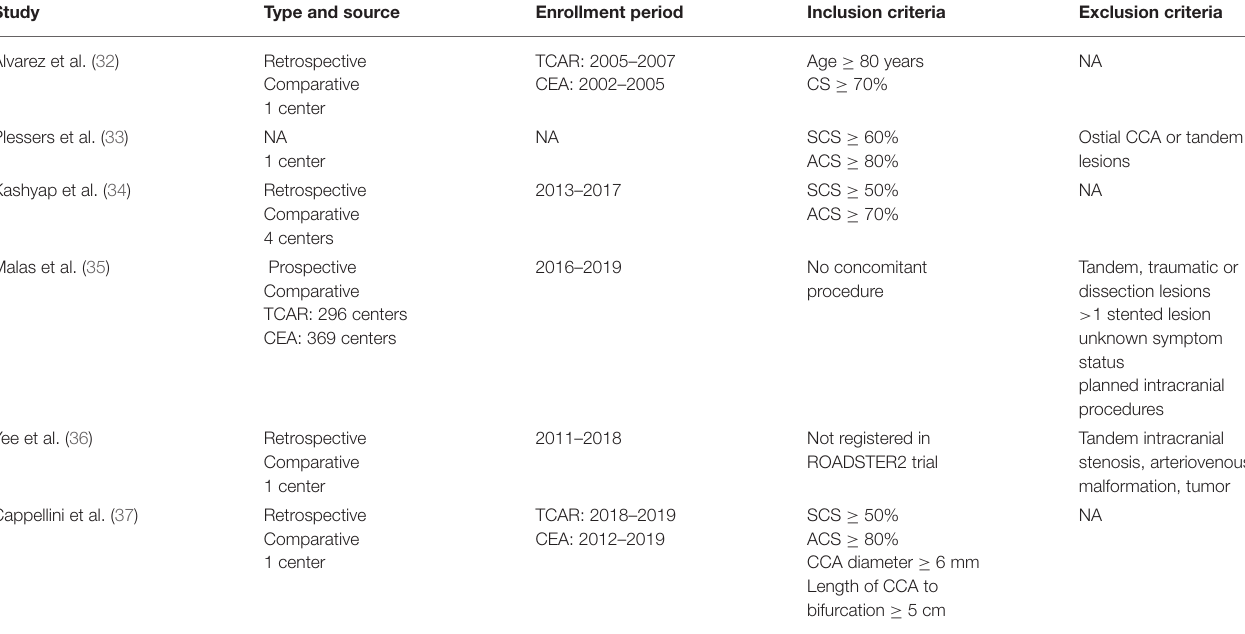
TABLE 1 | Characteristics of included